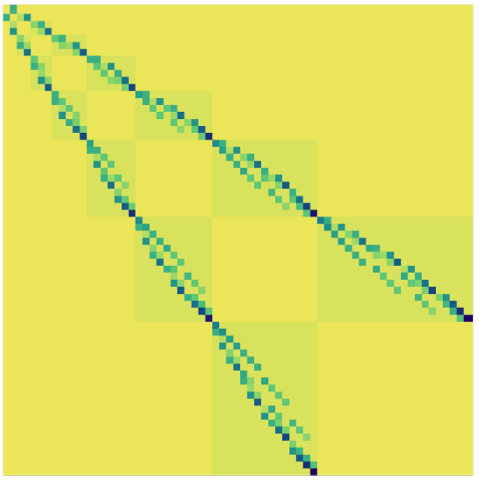
Figure 1 . [Left] Block tridiagonal structure of the Liouvillian matrix: the matrix elements are indexed by orthogonal descendants. Each block specifies transition amplitudes between two descendant states of adjacent levels and the individual values are the Lanczos coefficients. [Right] The Young’s lattice: the vertices correspond to integer partitions or descendant states and the edges are weighted by the Lanczos